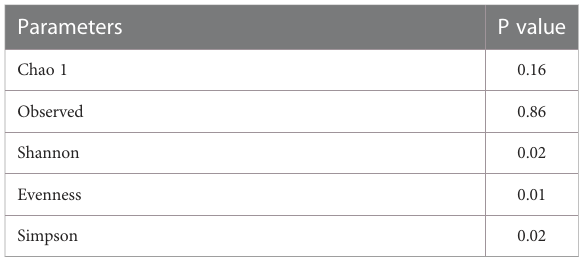
TABLE 1 The analysis of a